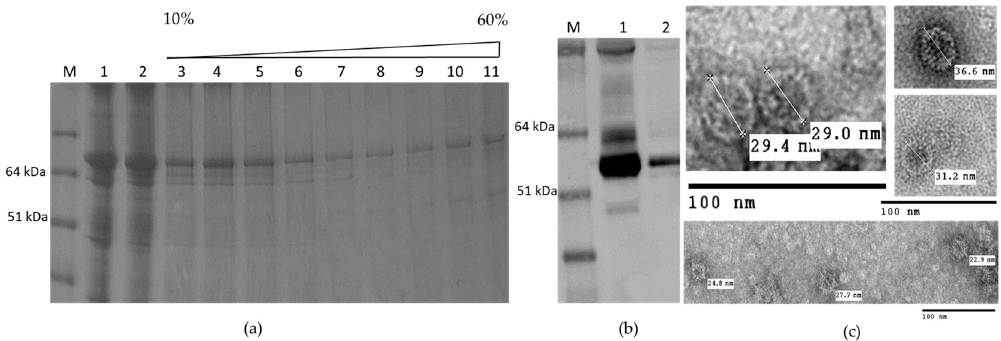
Figure 6. ( a ) SDS-PAGE of sucrose gradient of M2 HEV 110–610; M. Molecular weight marker (kDa);